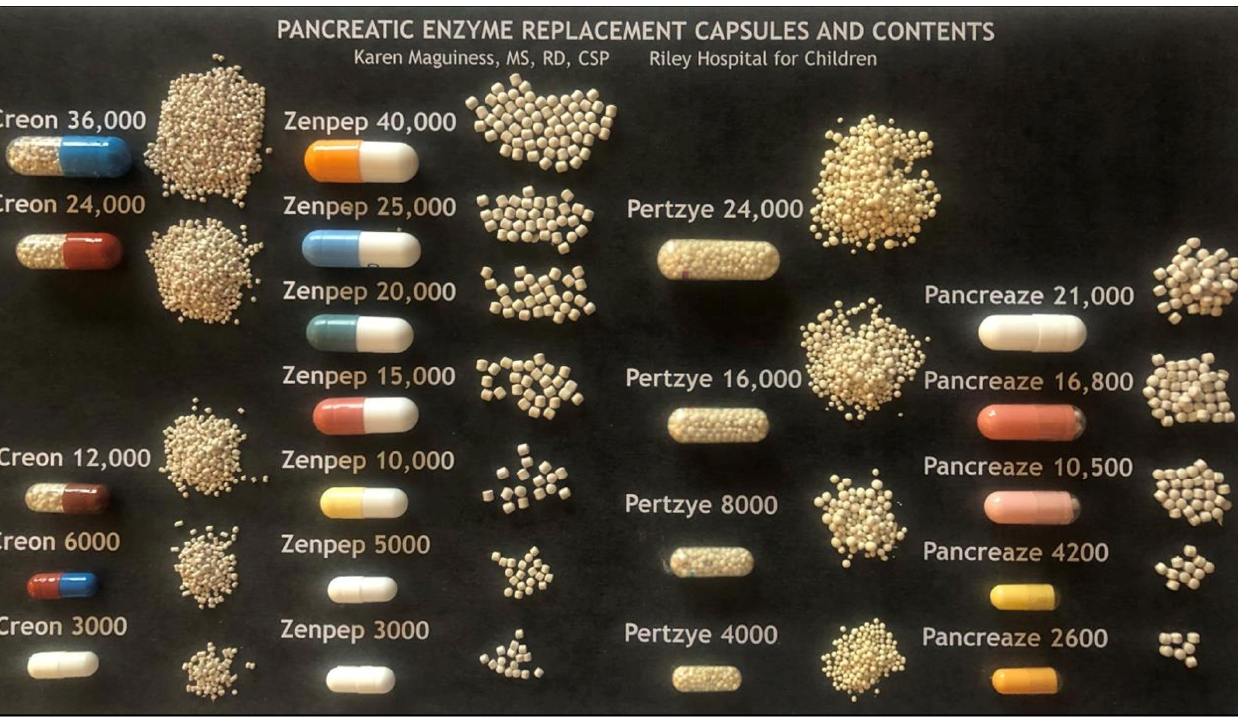
Figure 1. Figure 1. PERT Capsules and Contents. Reprinted with permission from Karen Figure 1. PERT Capsules and Contents. Reprinted with permission from Karen Maguiness, MS, RD, Maguiness, MS, RD, CSP, Riley Hospital for Children. CSP, Riley Hospital for